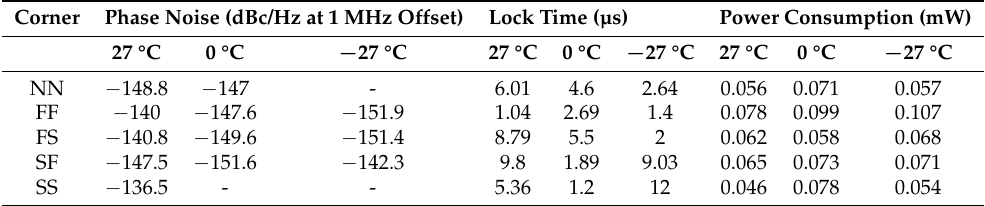
Figure 6. Comparison of the phase noise plots of novel PLL and conventional PLL. Table 2. An overview of the new PLL’s performance at various process corners and temperatures.